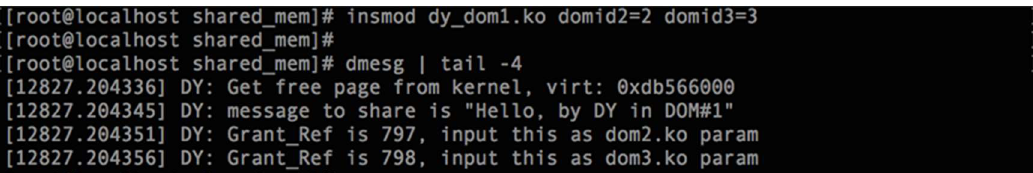
Figure 5. Create shared memory in VM1.